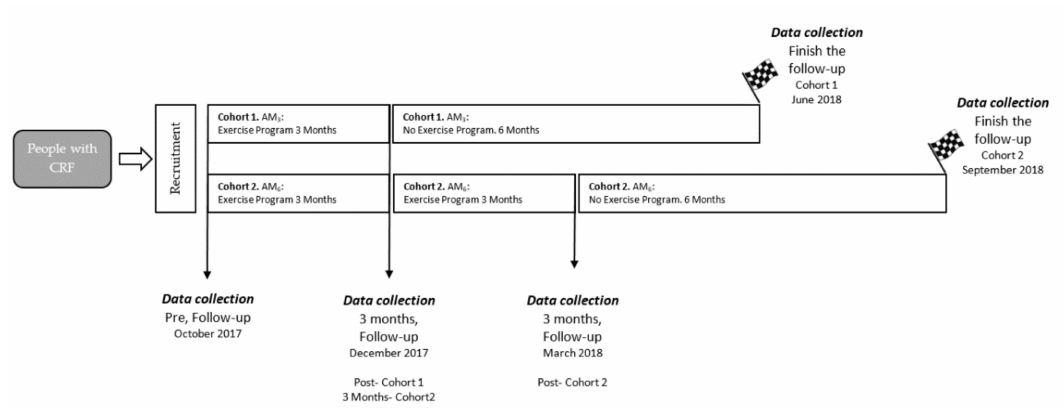
Figure 1. Prospective observational cohort design and testing procedures. CRF: cardiovascular risk factors, AM: Activa